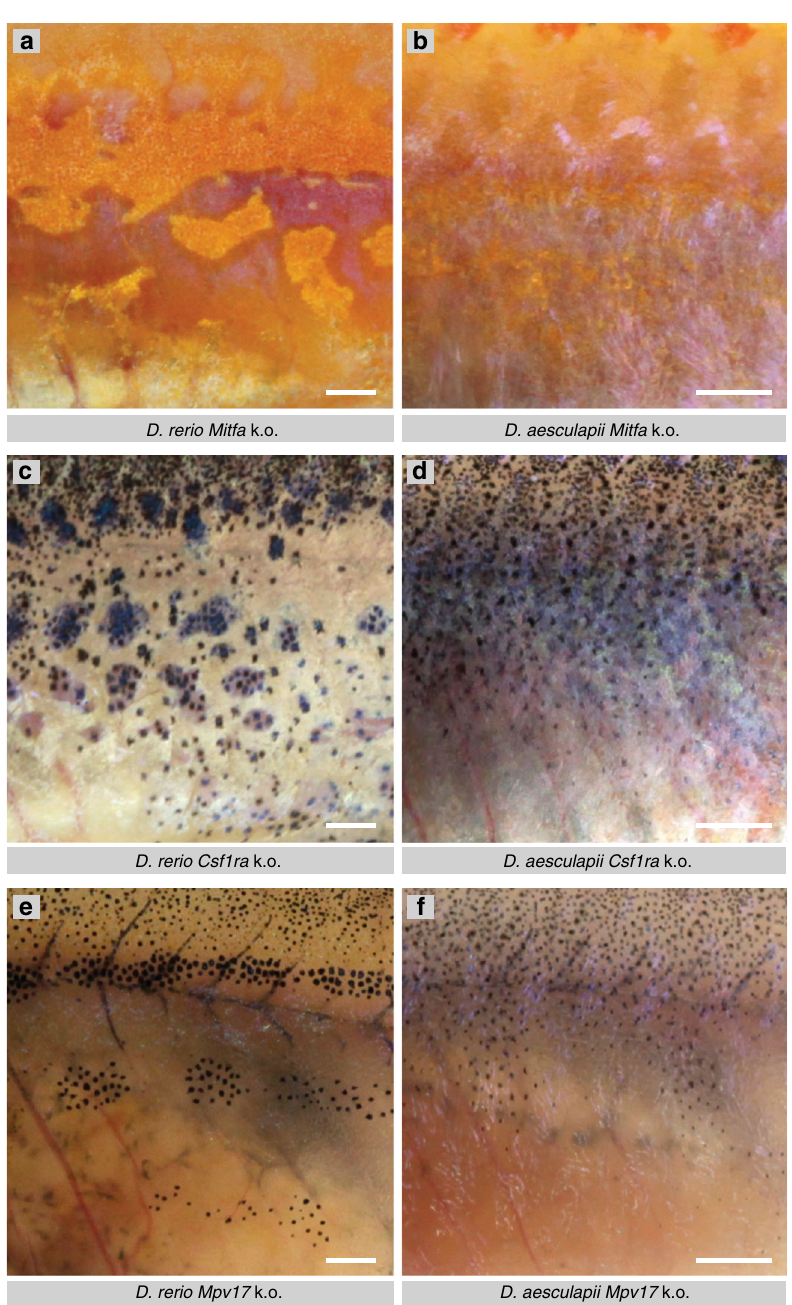
Fig. 3 Mutant phenotypes in D. rerio and D. aesculapii of genes required for individual pigment cell types. In D. rerio loss of one type of pigment cell type, a melanophores in Mitfa ( nacre ) mutants, c xanthophores in Csf1ra ( pfeffer ) mutants, or, e iridophores in Mpv17 ( transparent ) mutants, still permits rudimentary aggregation of dense iridophores ( a ) or melanophores ( b , c ). In D. aesculapii , loss of melanophores, b , in Mitfa mutants ( n > 100) or loss of xanthophores, d , in Csf1ra mutants ( n > 50), abrogate any residual pattern formation. However, vertical melanophore bars still form in Mpv17 mutants ( n = 8), f despite the absence of iridophores. All images show representative examples of the corresponding genotypes. Scale bars correspond to 1